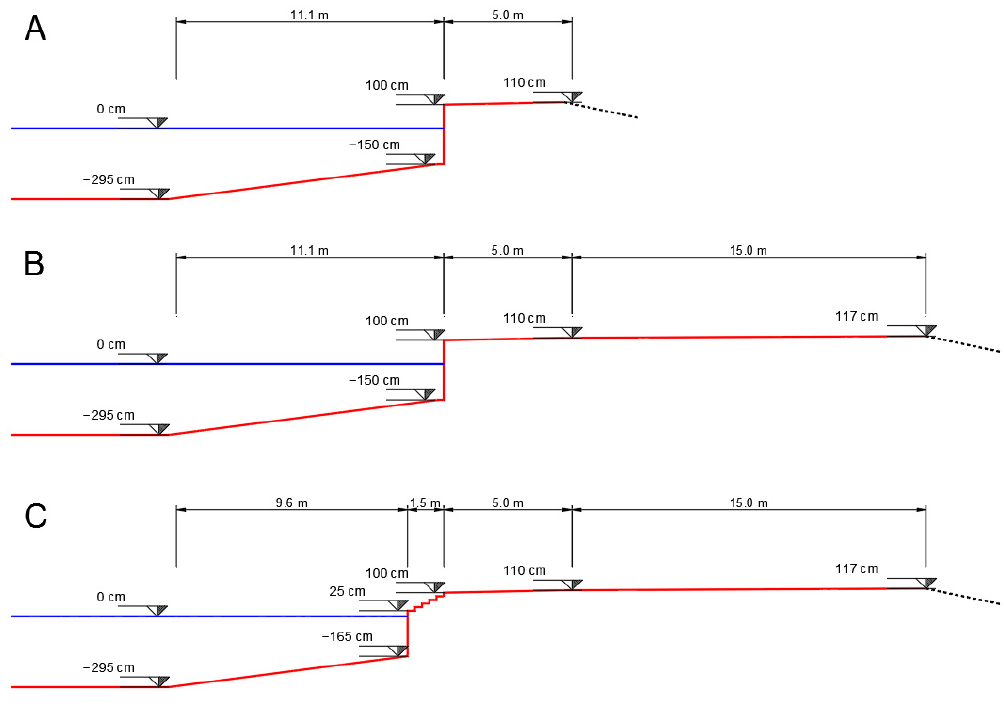
Figure 6. Geometries of the tested sections: type A , B and C .